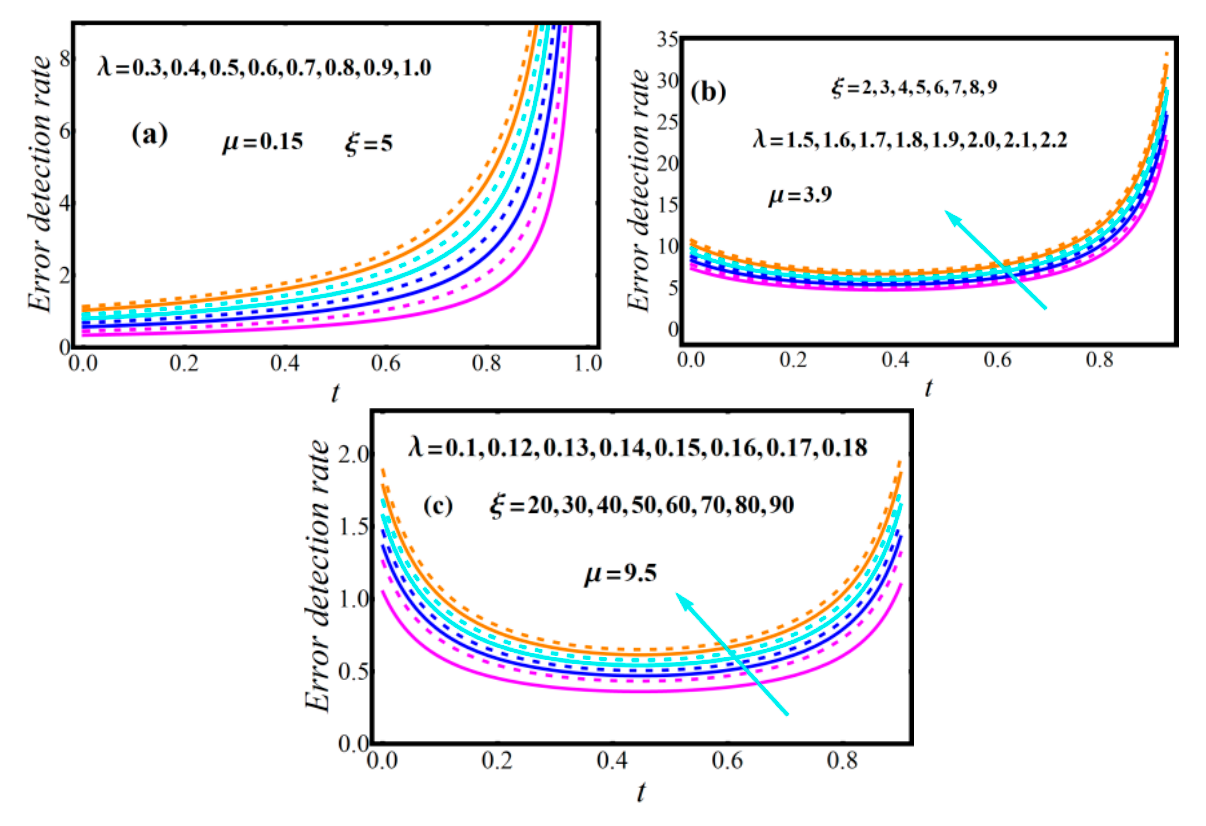
Figure 3. Plots of the number of remaining faults’ function of the NHPP–NPF model.